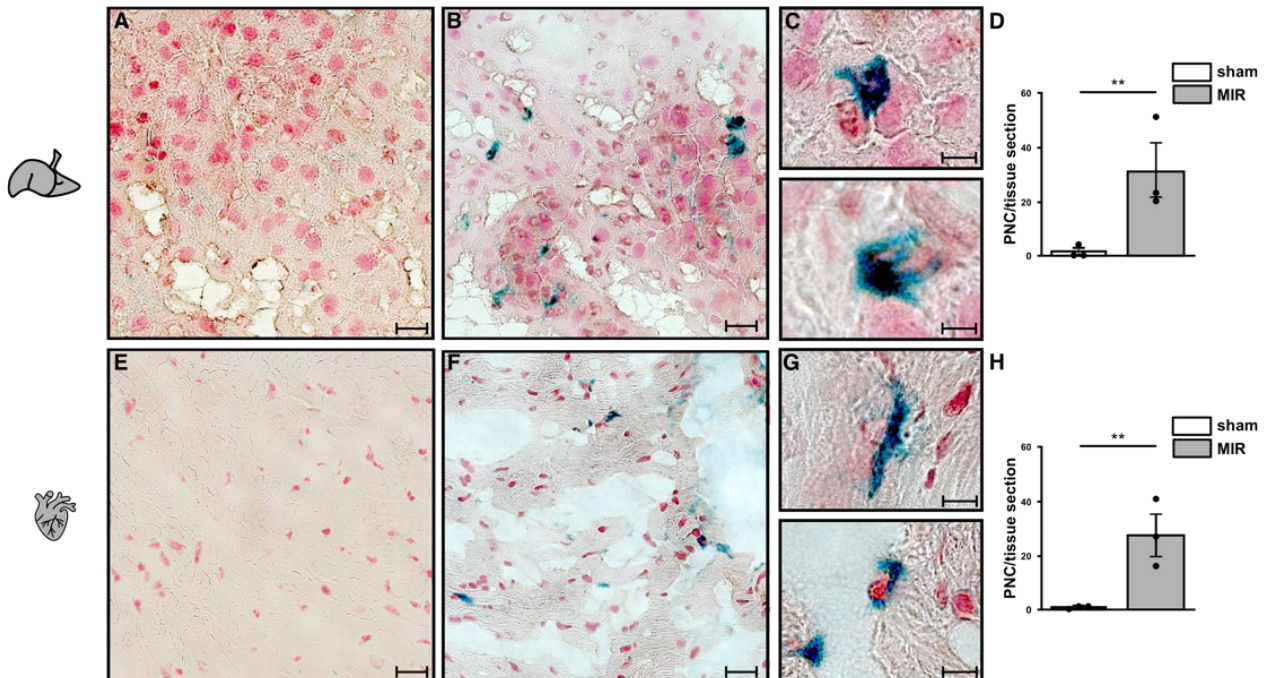
Figure 7. Immunohistological analysis of PNCs within the infarcted tissue. Representative histo- logical images of liver ( A – C ) and heart tissue ( E – G ) without ischemia ( A , E ) and after IR ( B , F ). Scale bars 10 µm. PNCs were stained for neutrophils (anti-Ly-6B2; blue) and platelets (anti-CD41; black). Selected ( C ) liver and ( G ) heart sections magnification (1000×) showing neutrophils (blue) co-stained with platelets (black). Structural staining of organ cells was achieved by nuclear fast red. Control negative and IgG staining are shown in Figure A6 (liver) and Figure A7 (heart). Statistical analysis of PNCs in ( D ) liver and ( H ) heart sections. n = 3 mice; unpaired Student’s t -test with ** for p < 0.01.